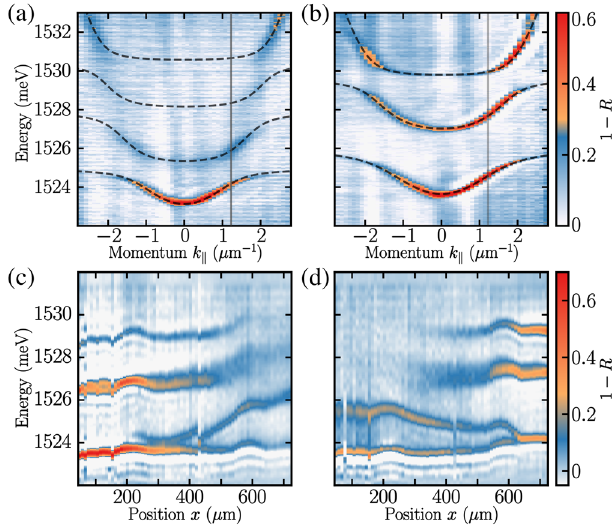
FIG. 2. Electrically controlled polariton landscape. (a) Normalized white-light reflectivity spectra showing the polaron-polariton dispersion at the nominal electron density. (b) Exciton-polariton dispersion in the depleted regime ( Δ V L ¼ − 6 V). Dashed lines are coupled oscillators fits to the data. (c),(d) Normalized white-light reflectivity spectra at k k ¼ 1 . 2 μ m − 1 [vertical line in(a) and (b)] asa function ofpositionwitha negative bias voltage applied to the left contact ð Δ V L ¼ − 2 . 4 V Þ (c) and to the right contact ð Δ V R ¼ − 2 . 4 V Þ